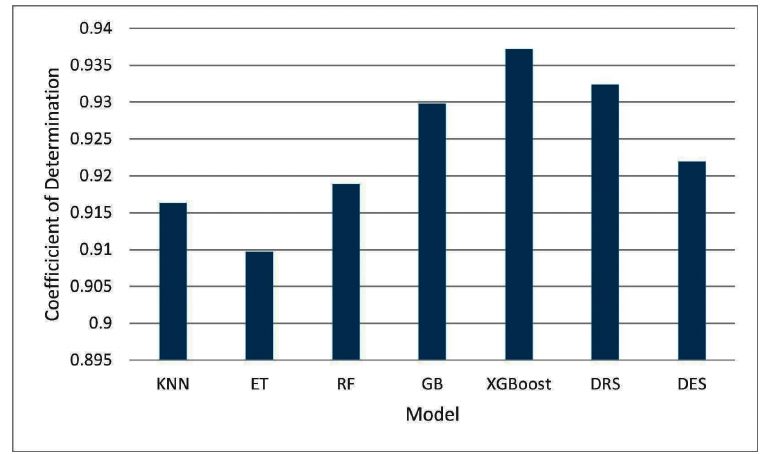
Figure 13. Coefficient of determination of models from dataset 2.